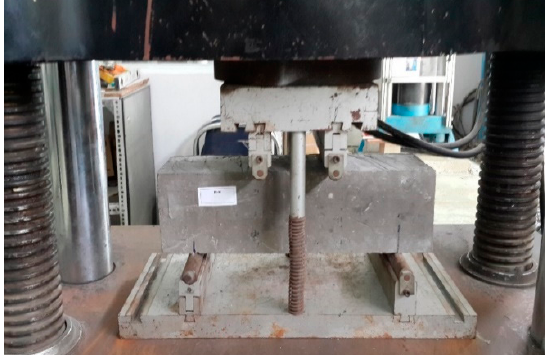
Figure 8. Flexural test. Figure 8. Flexural